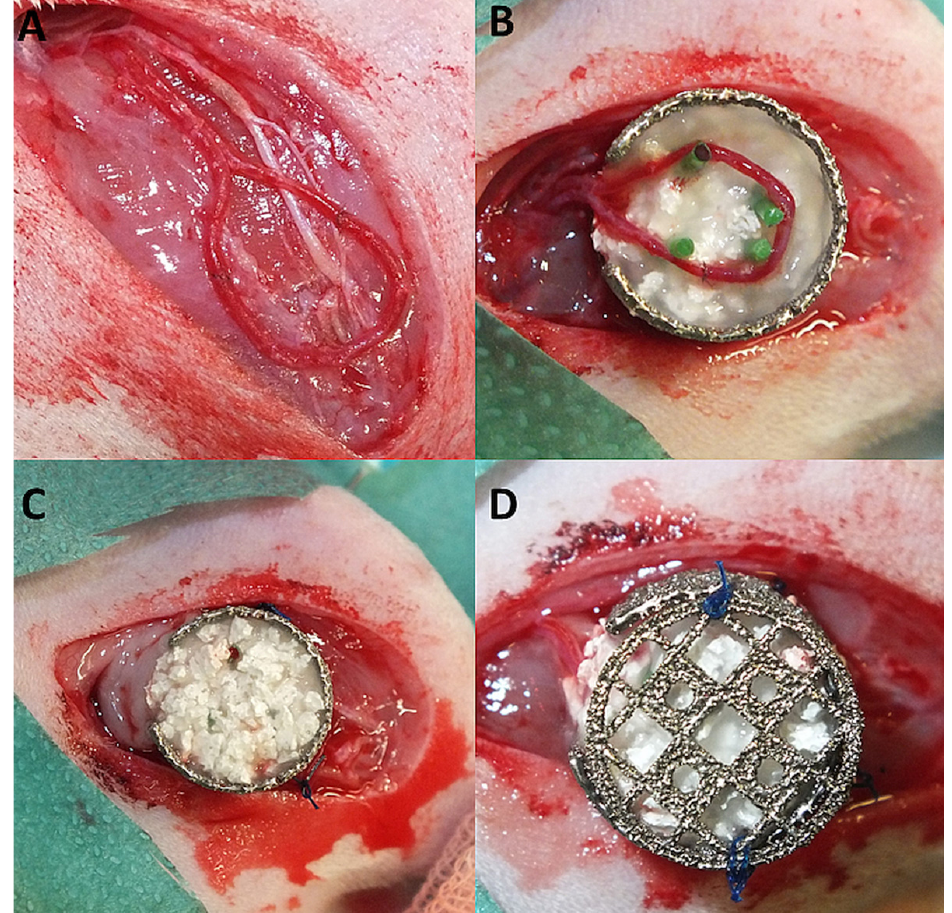
Figure 1. AV loop operation. First, the vein graft was microsurgically anastomosed between the saphenous vessels ( A ). Thereafter, the half-filled titanium porous chamber was sutured on the thigh musculature and the AV loop placed on top of the matrix ( B ). Finally, the second half of the matrix was added, the chamber closed with a lid and the skin closed ( C , D